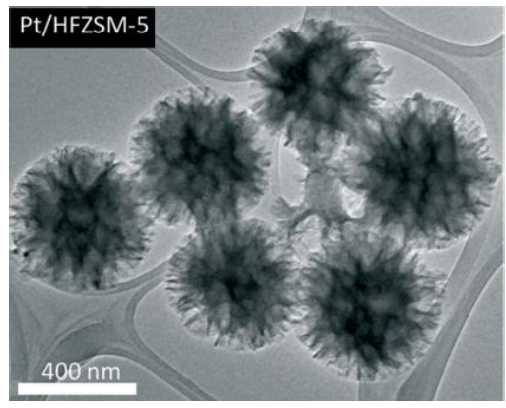
Figure 8. TEM image of fibrous ZSM-5 zeolite [63]. Copyright Royal Society of Chemistry, 2016.